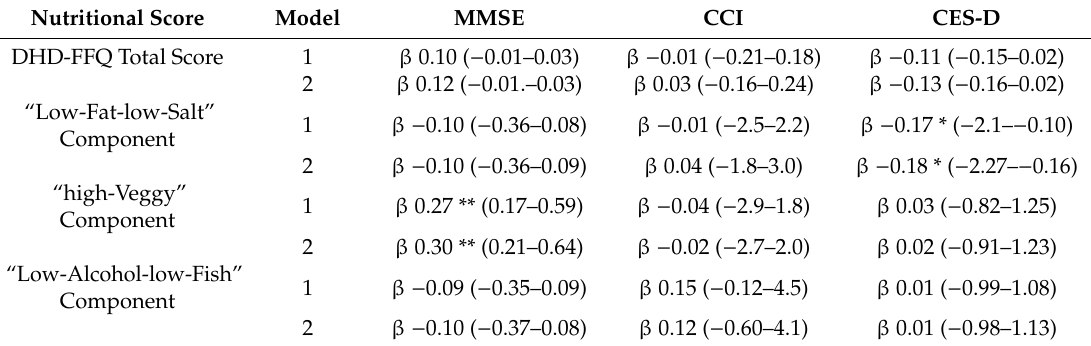
Table 3. Linear regression models of PCA components and clinical characteristics.